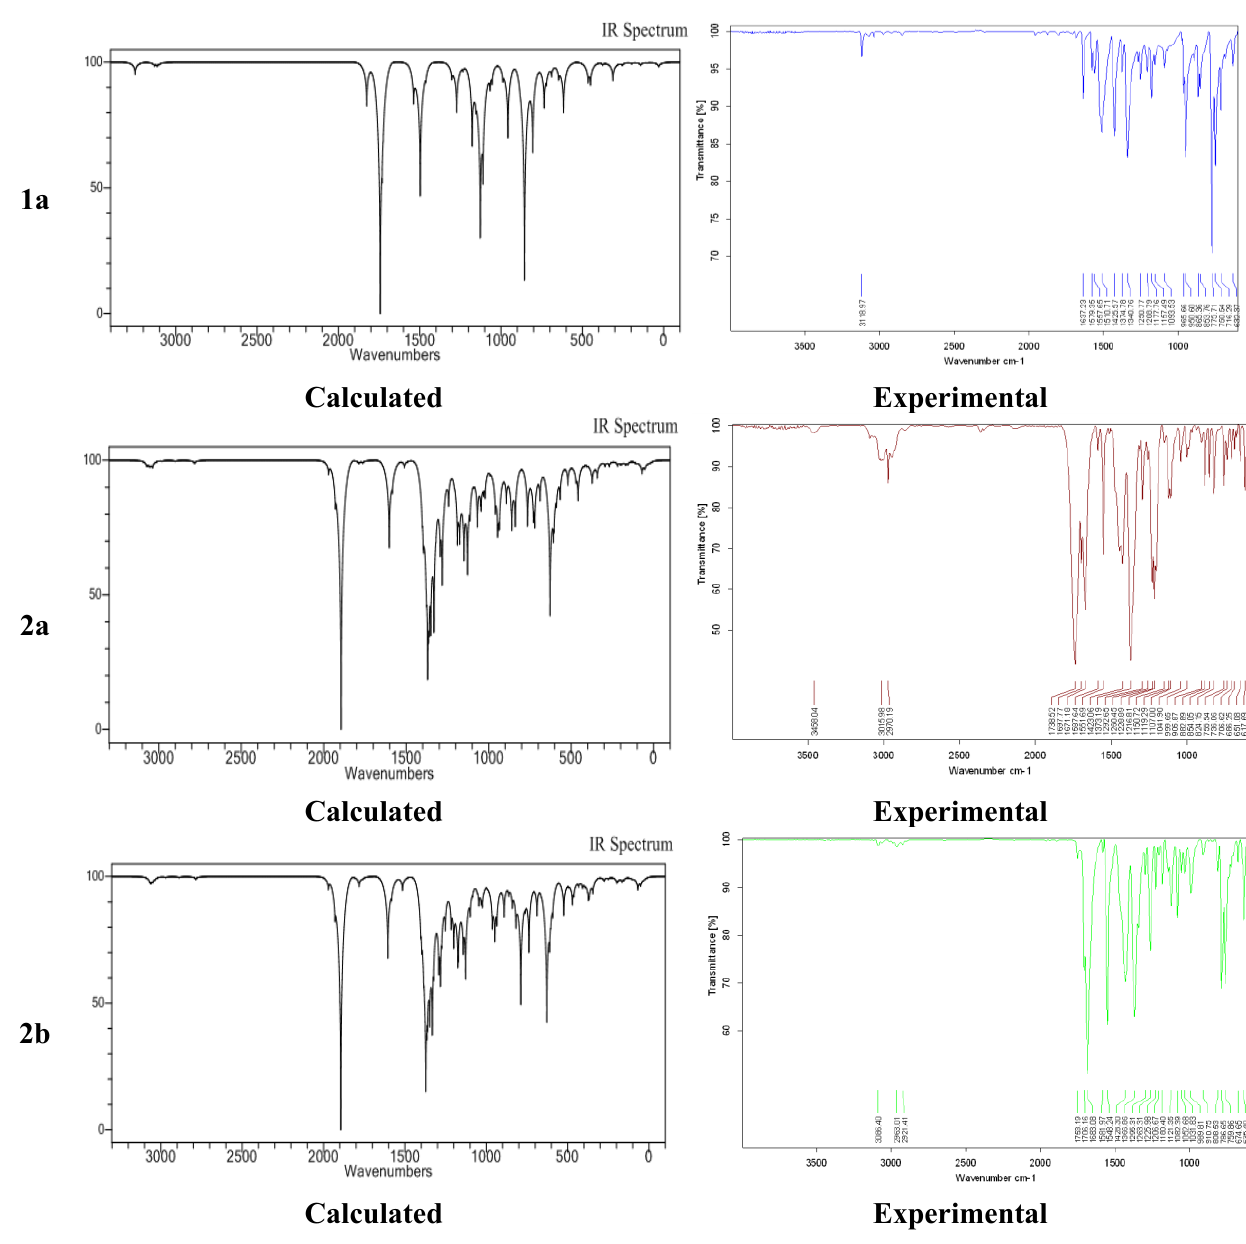
Figure 4. Experimental and calculated IR spectra for 1a and 2a , b